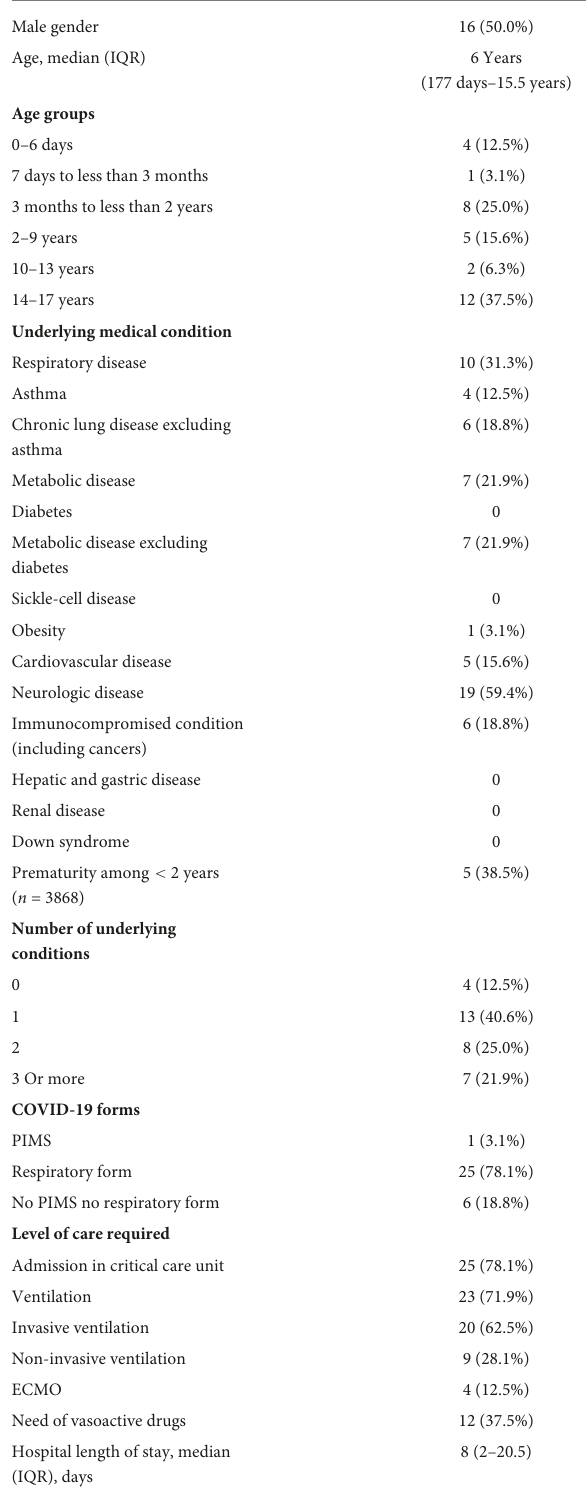
TABLE 2 Characteristics of the deceased children hospitalized with